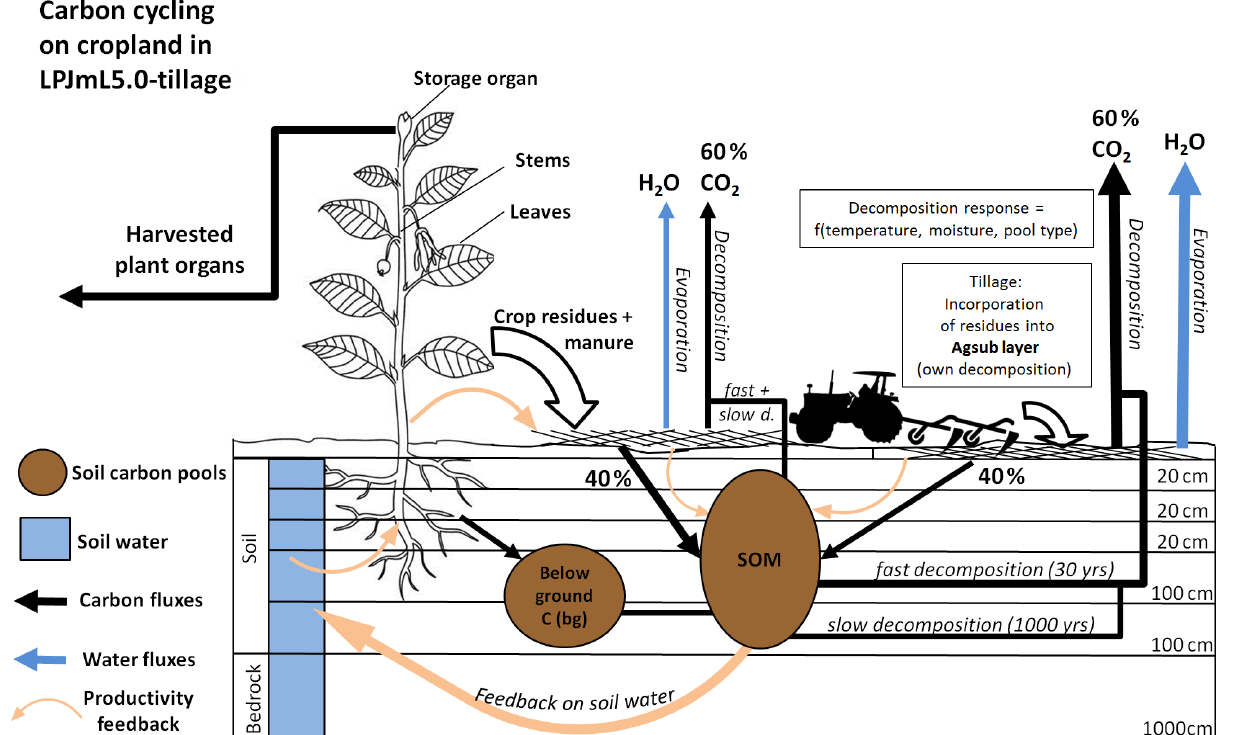
Figure 1. Carbon cycling on cropland and productivity feedbacks from plants to residues as well as soil stocks and soil water, as modeled in LPJmL5.0-tillage. Arrows indicate fluxes; boxes and circles are